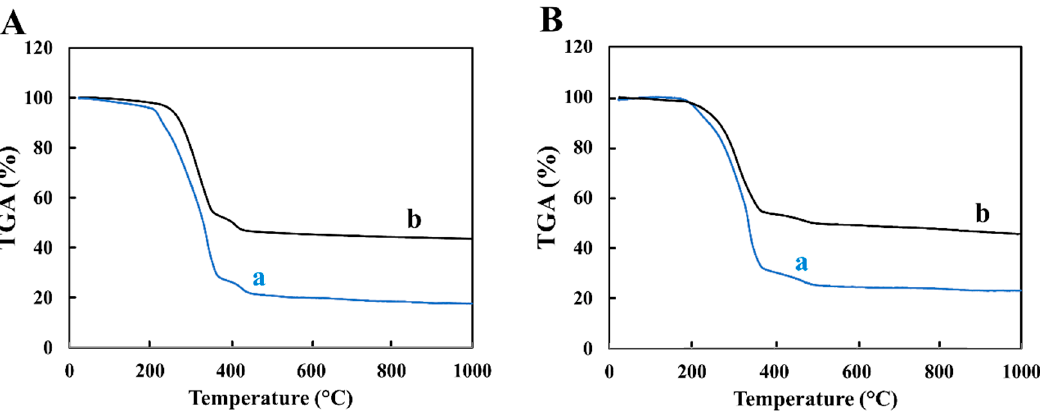
Figure 6. TGA data for composites prepared from 10 gL − 1 PEMA and 3 gL − 1 LA solutions in ethanol, containing ( A ) (a) 3, (b) 10 gL − 1 hydroxyapatites, and ( B ) (a) 3 and (b) 10 gL − 1 silica.